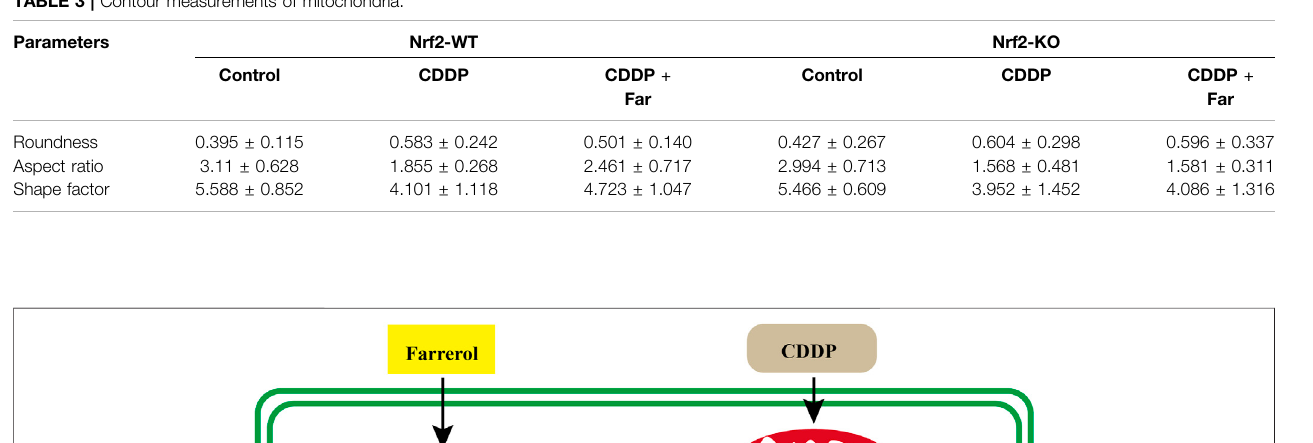
FIGURE 9 | The protective effect of farrerol against CDDP-related CKD and its potential mechanism. Cisplatin can accumulate in epithelial tubule cells, causing mitochondrial dysfunction and excessive ROS. Damaged cells can induce in fl ammation by triggering the activation of p-NF- κ B/NLRP3. In addition, the generated ROS orchronicunresolvedin fl ammationcanalsostimulatetheproductionofrenal fi brosis andthedevelopmentofCKD via TGF- β /Smadsignaling.FarrerolcanactivateNrf2/ ARE, then increase PINK1/Parkin-mediated mitophagy and eliminate damaged mitochondria.